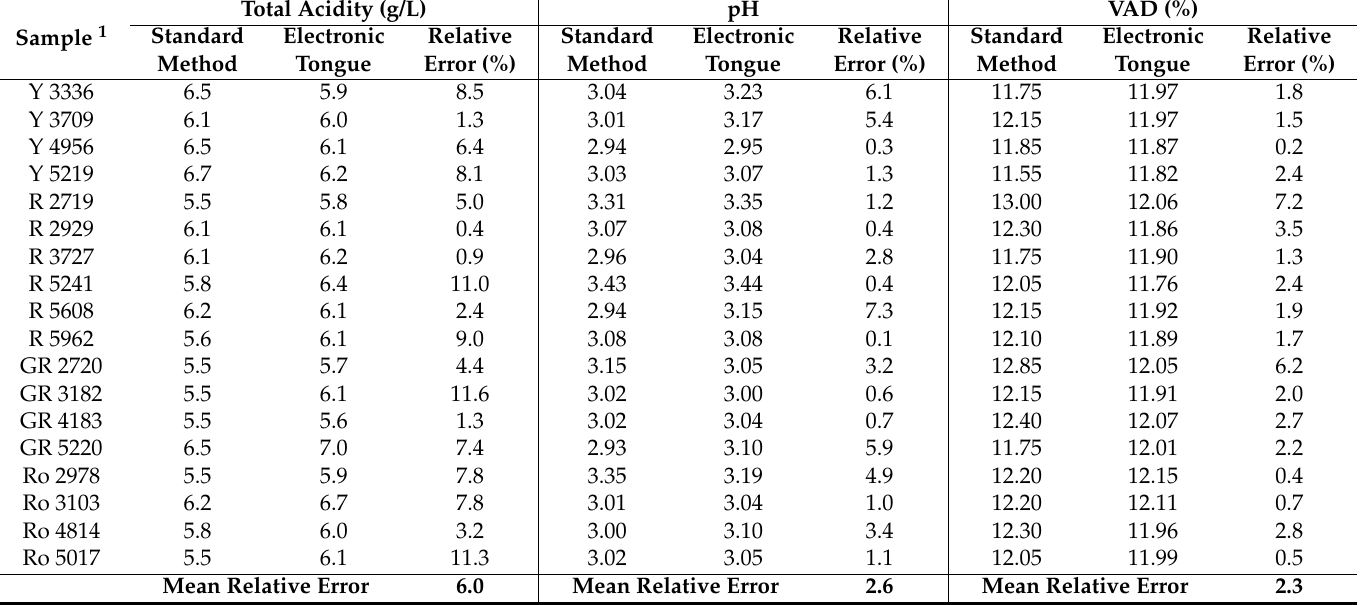
Table 4. Results of legal parameter quantification with the electronic tongue using PLS-1 regression. Standard method data were provided by